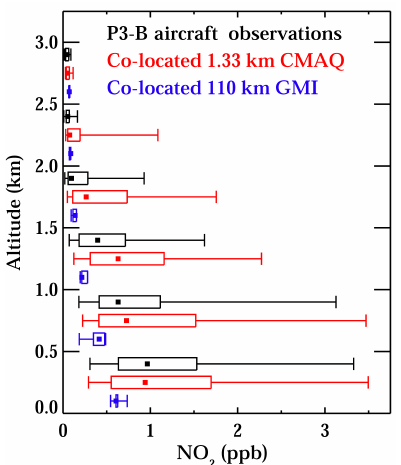
Figure 6. Vertical profiles of NO 2 binned in 500m intervals (0–0.5, 0.5–1km, etc.) showing the 5, 25, 50, 75, and 95 percentiles within ± 2h of the OMI overpass time. Black: 1min averaged data from the P3-B aircraft during July 2011 DISCOVER-AQ Maryland. Red: model output from CMAQ matched spatially and temporally to the P3-B measurements at 1min intervals. Blue: July 2011 monthly mean model output from GMI matched spatially to the P3-B mea- surements at 1min intervals. In all cases, the squares indicate the median